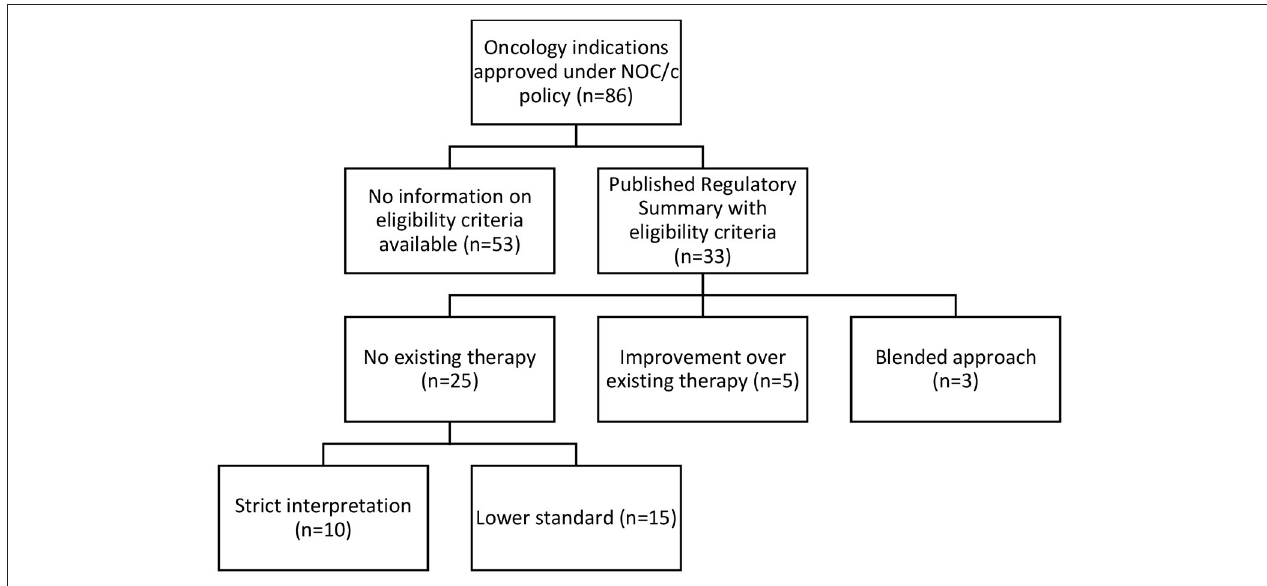
FIGURE 2 | Categorization of NOC/c eligibility